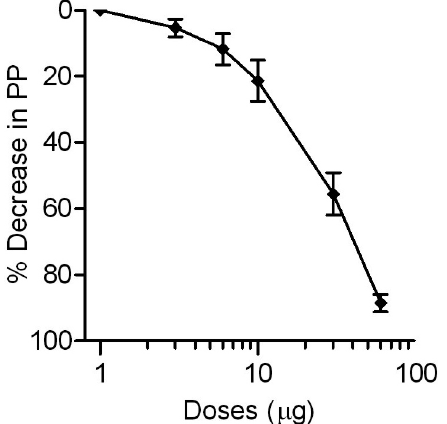
FIGURE 2 - Vasodilator effect of Alpinia purpurata hydroalcoholic extracts on MVB pre-contracted with NE. Each point represents the average ± SE, n ≥